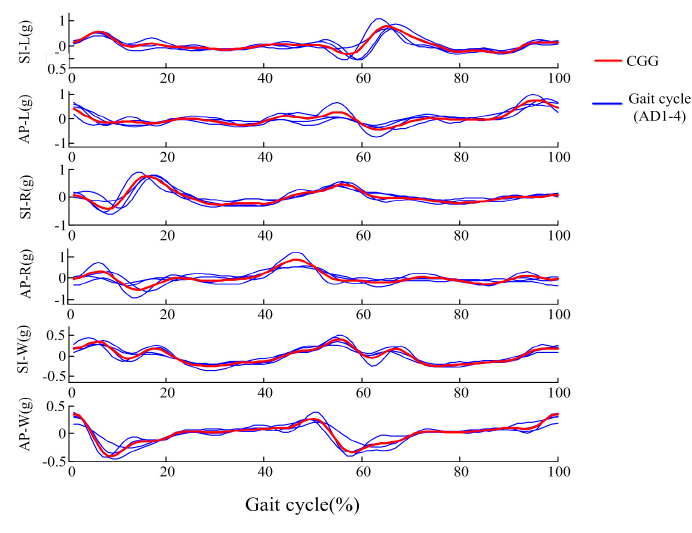
Figure 5. AGGs of AD1~AD4 and Characteristic Gait Graph (CGG).